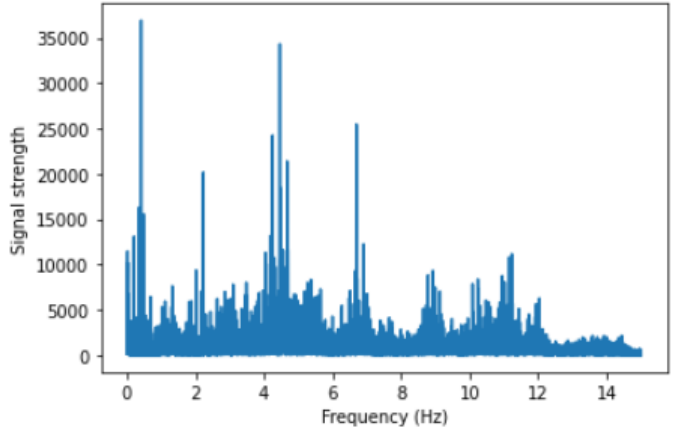
Figure 6. Frequency-domain analysis for all counted